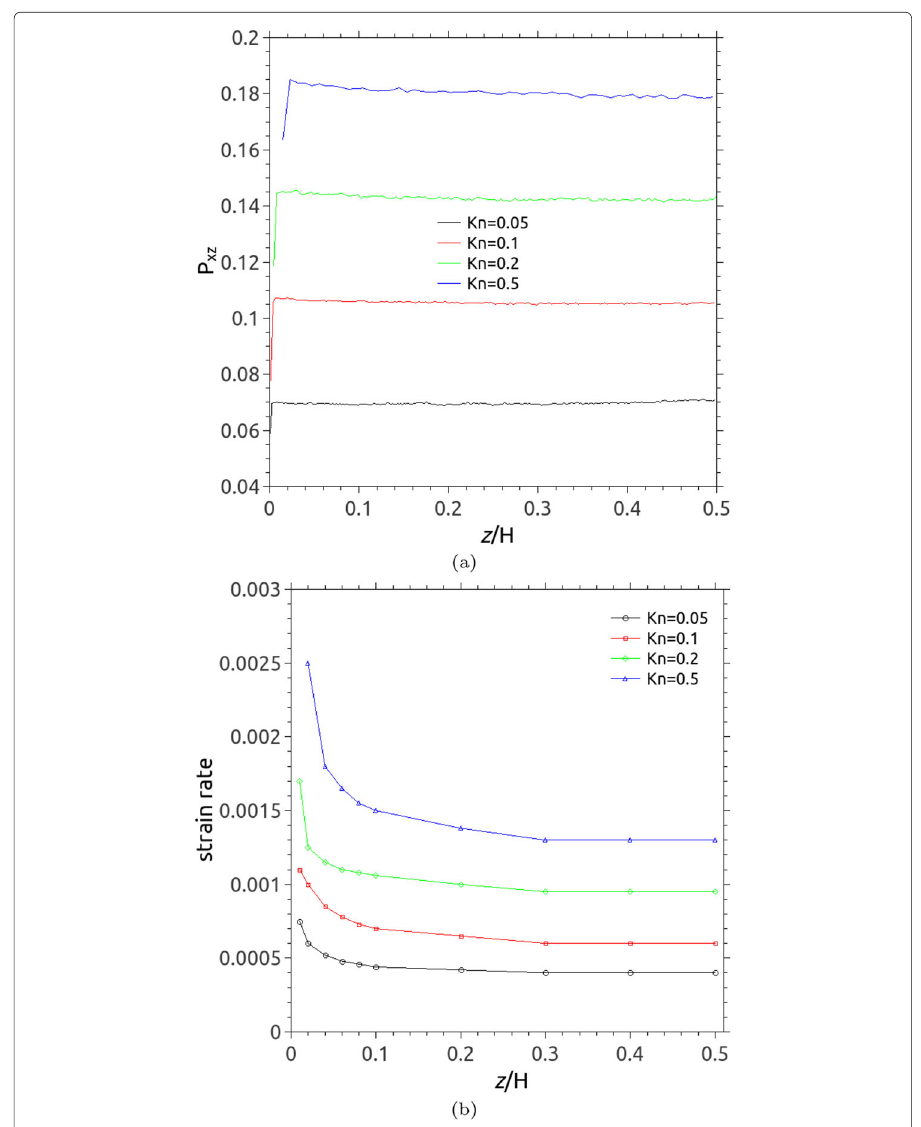
Fig. 6 Local shear stress and strain rate in micro-Couette flows using MD for Kn = 0.05, 0.1, 0.2 and 0.5: a the shear stress P xz normal to the solid wall; b the strain rate in the xz panel. The data is plotted for only half the channel (i.e. above one of the